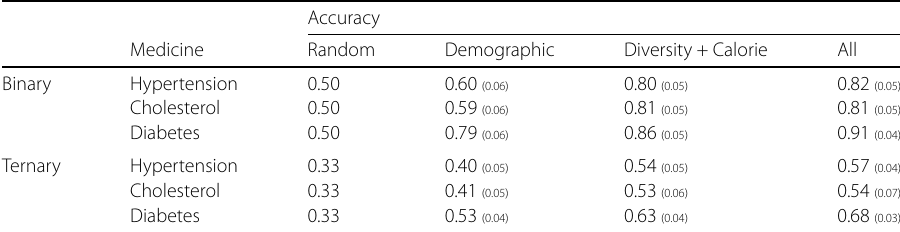
Table 3 Accuracy of Random Forest classifier in predicting the prevalence of diseases in London areas. The results of two classifiers are reported: (i) binary classification of areas in the top and bottom quartiles of the three diseases’ prevalence; (ii) ternary classification where an equally-sized class containing training instances randomly sampled from the two central quartiles is added. The predictive features are six: gender, average age, education level, item weight, nutrient diversity, and calorie concentration. The accuracy of a random baseline classifier is 0.5 for the binary case, and 0.33 for the ternary case. Numbers in parenthesis represent the standard deviation on the 10-fold cross validation